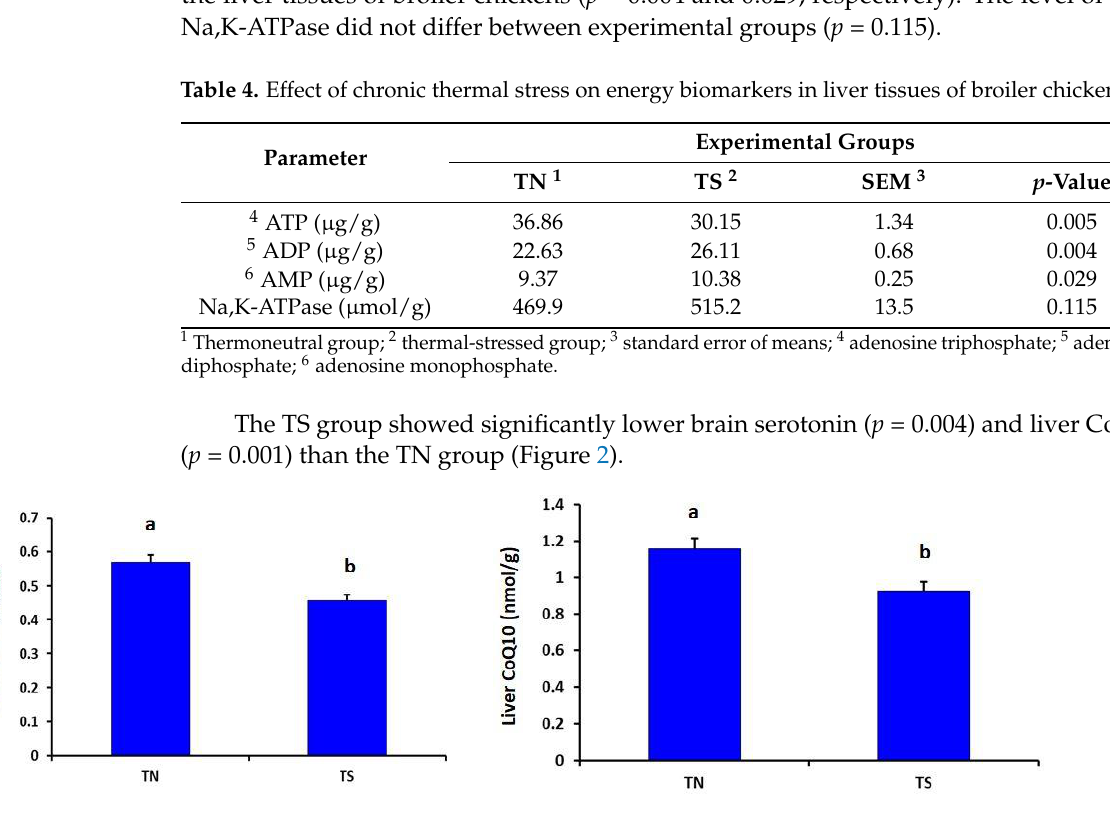
Figure 2. Effects of chronic thermal stress on brain serotonin and liver CoQ10 of broiler chickens ( p = 0.004 and 0.001, respectively). TN: Thermoneutral group; TS: Thermal-stressed group. a,b Values with different superscripts differ signifi- cantly.